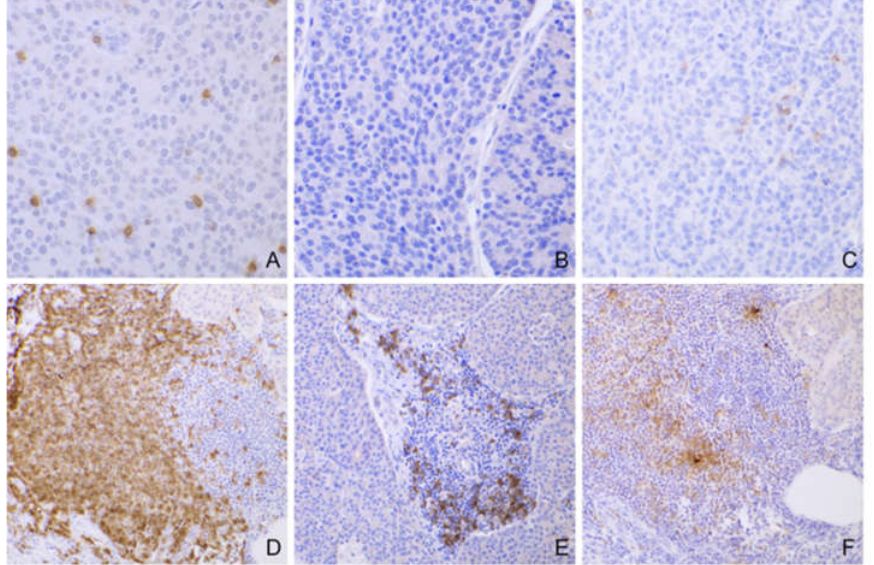
Figure 1. Tumor-infiltrating lymphocytes in canine AGASACAs. ( A ) Numerous intratumor CD3+ lymphocytes (case #22; 40× magnification). ( B ) Absence of intratumor CD20+ lymphocytes (case #22; 40× magnification). ( C ) Scattered intratumor PD-1+ lymphocytes (case #22; 40× magnification). ( D – F ) Peritumor lymphocytes in nodular aggregates are composed of a mixture of CD3 (D), CD20, ( E ) and PD-1 ( F ) positive lymphocytes (case #5; 20× magnification).